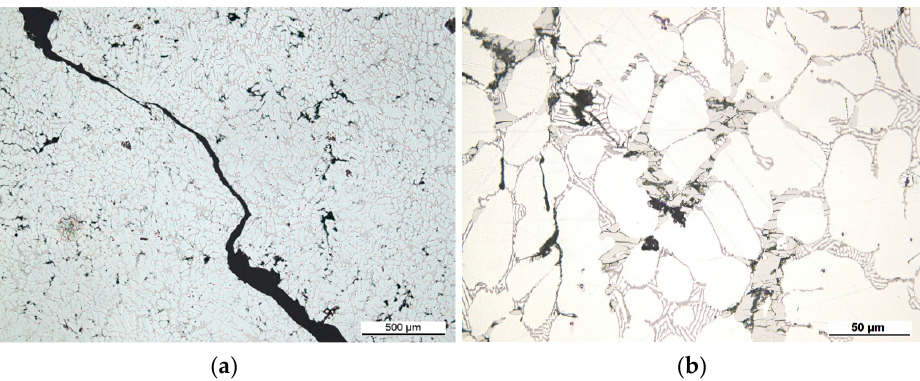
Figure 5. Cross-sectional micrographs of fracture surface after compression load showing the crack propagation of the sub-cracks near the main crack and its interaction with the microstructural features ( a , b ).